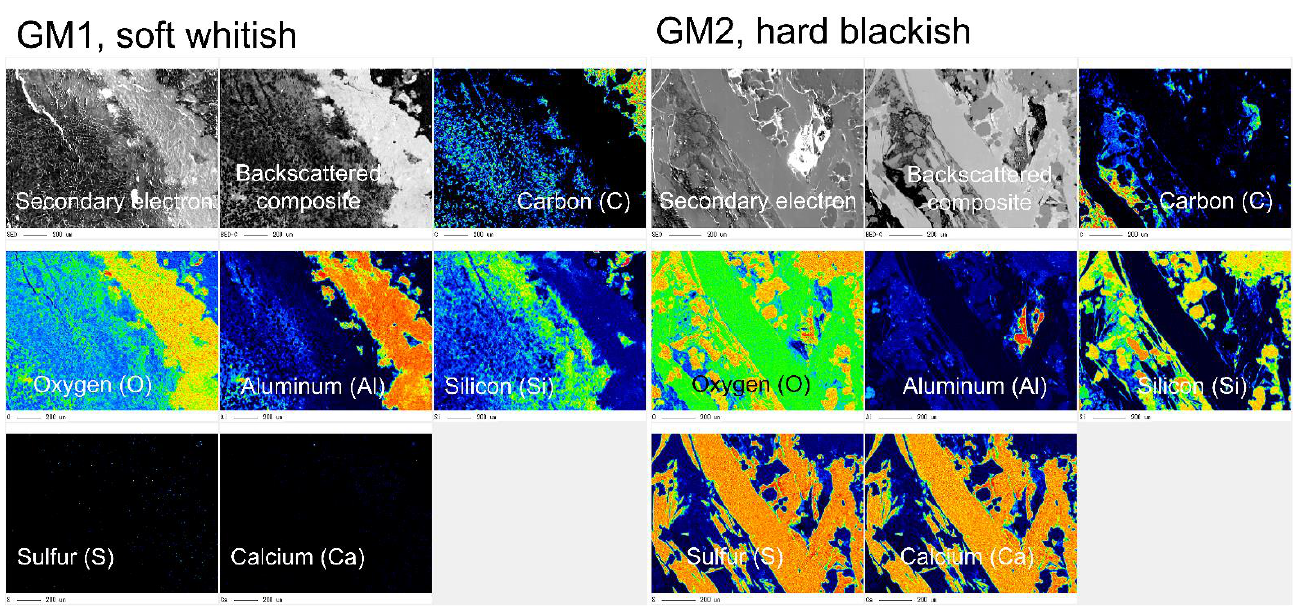
Figure 5. EPMA images of cross-sections of two speleothems, GM1 ( left ) and GM2 ( right ). Warm and cool colors indicate high and low relative abundances, respectively; black areas reveal the ab- sence or less-than-detectable presence of elements.